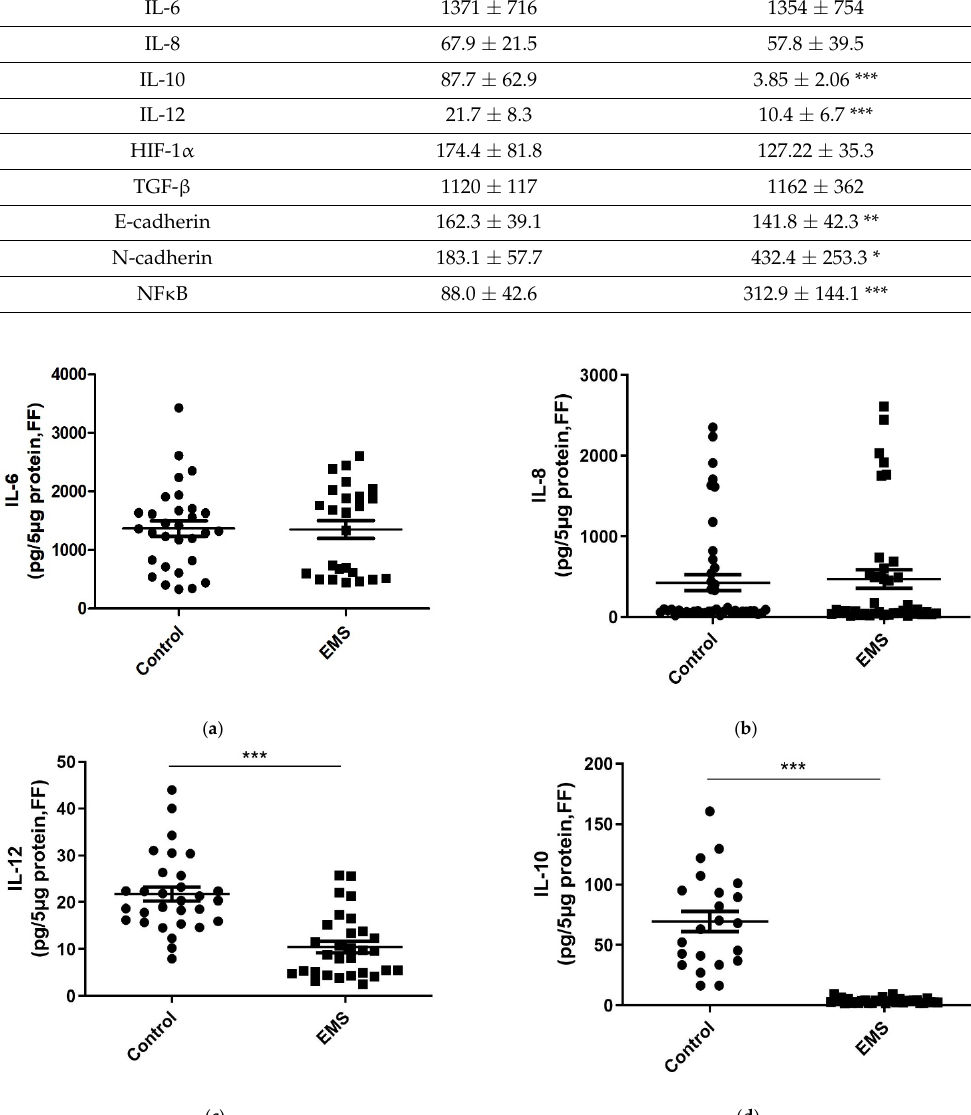
Table 3. Biochemical parameters measured in FF, collected at the pick-up day, from control women and patients with endometriosis. IL-6, IL-8, IL-10, HIF-1 α , and NF κ B are expressed as pg/5 ug total proteins. IL-12, TGF- β , E-cadherin, and N-cadherin are expressed as ng/5 ug total proteins. All the data are expressed as mean ± SD. Statistical analysis was performed by unpaired t -test. * p < 0.05, ** p < 0.01, *** p < 0.001 vs. control women.